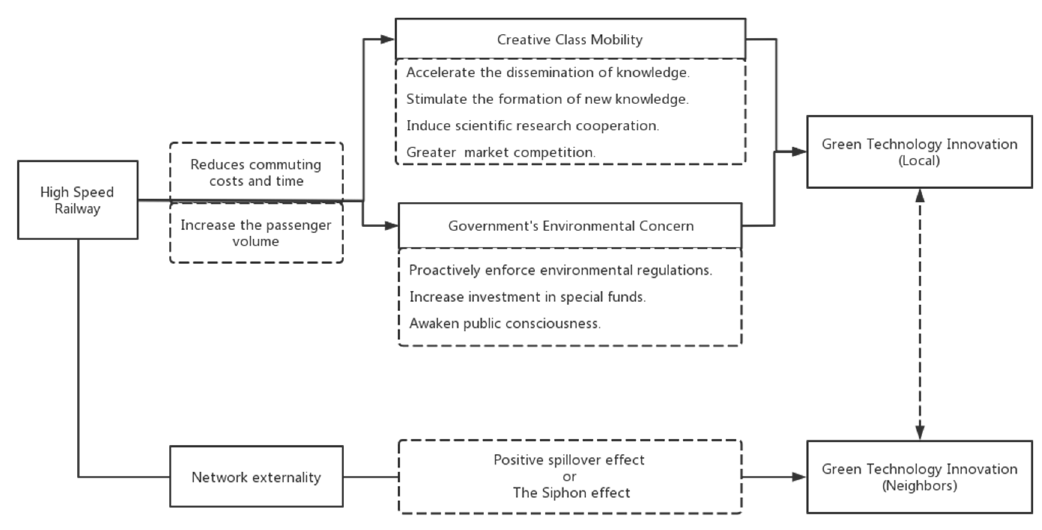
Figure 1. The conceptual diagram.